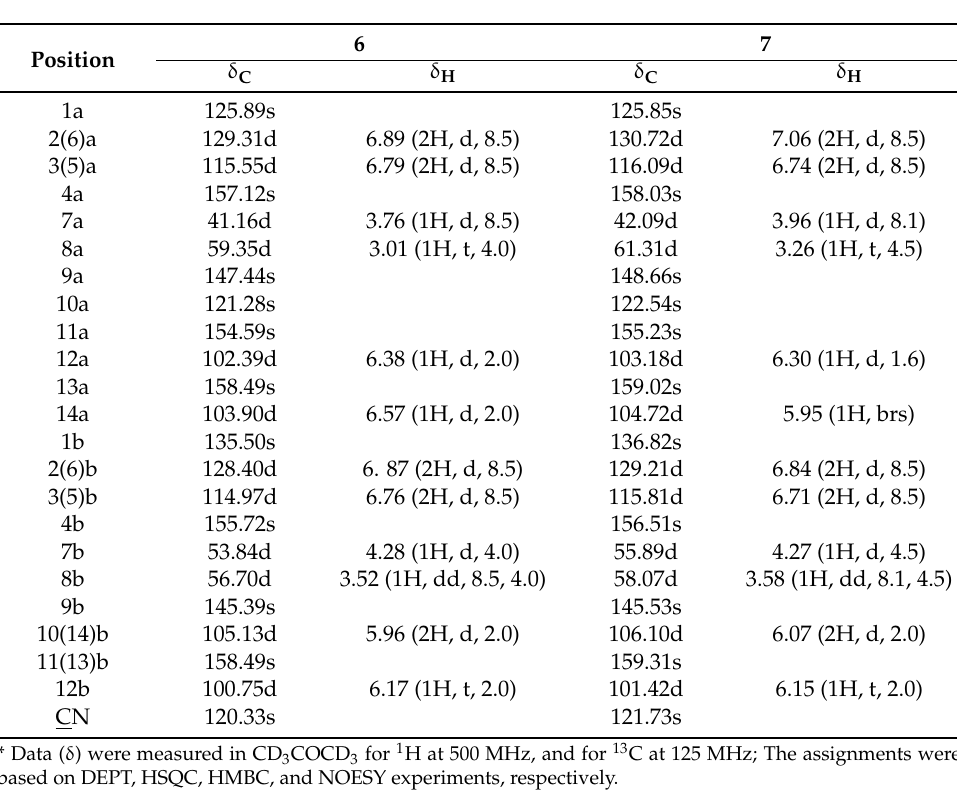
Table 2. 1 H- and 13 C-NMR spectroscopic data of 6 and 7 * .